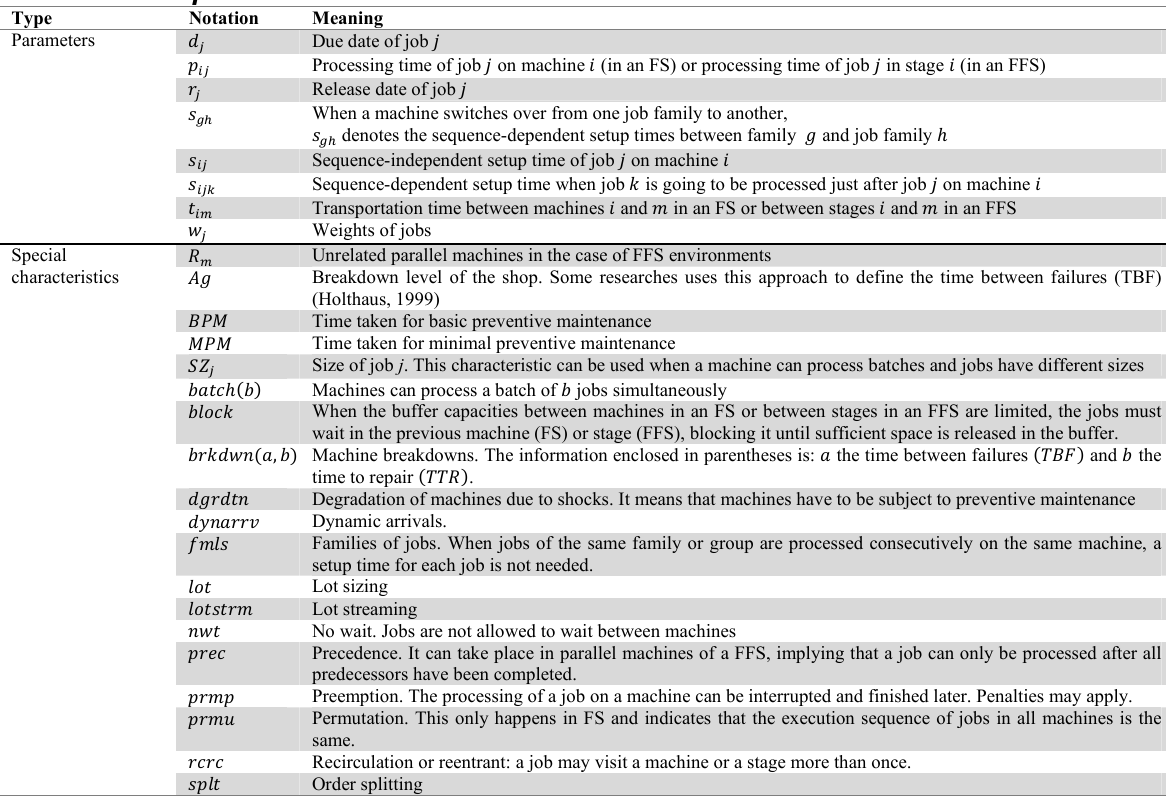
Table 1 Notation used in (cid:2236) field